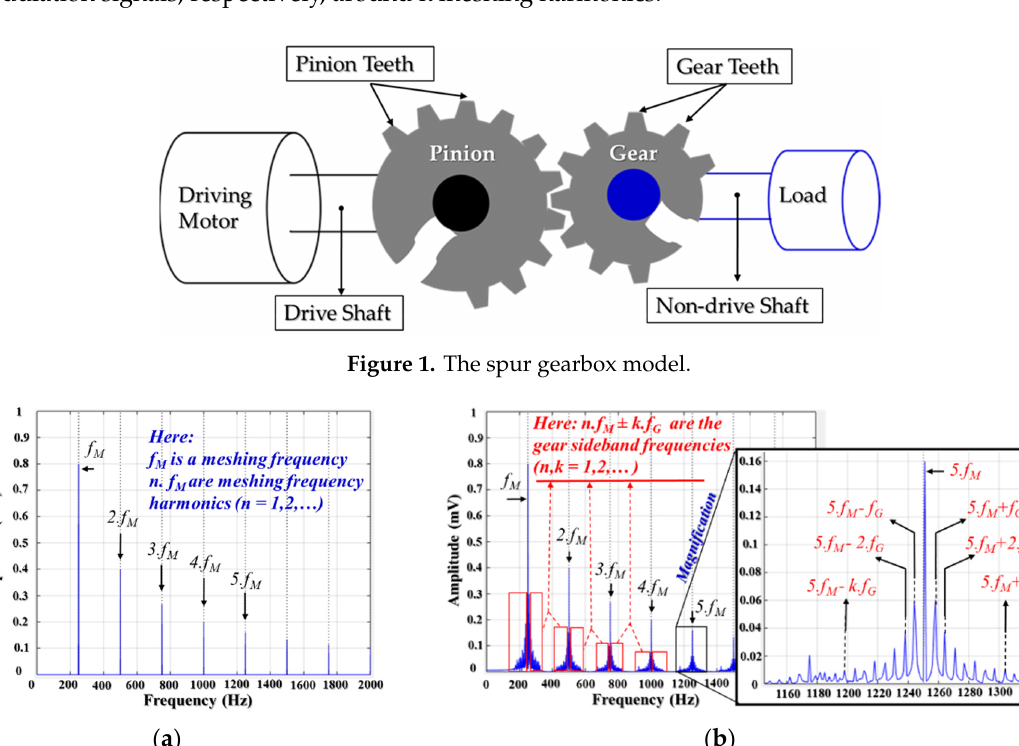
Figure 2. The frequency spectrum of the gearbox vibration signal: ( a ) a healthy gearbox and ( b ) a faulty gearbox.